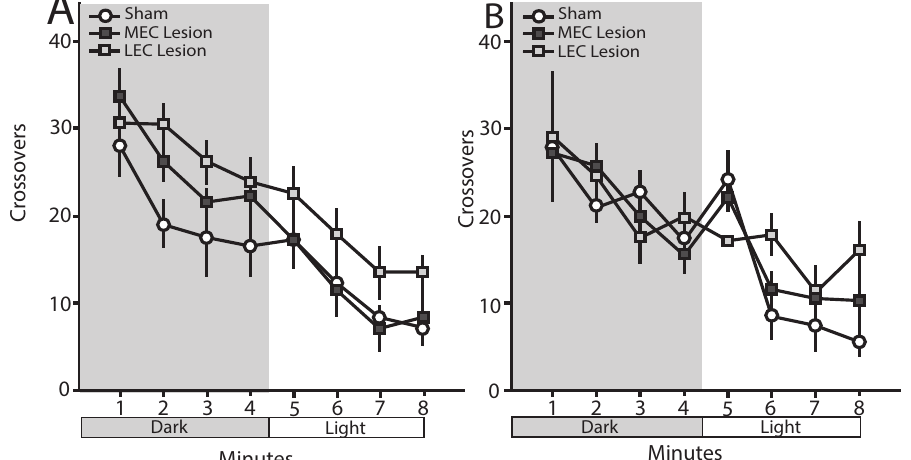
Figure 5. Mean (±SEM) number of crossovers in an open field during a 8-min test with four minutes of dark and four minutes of light. ( A ) Mean crossovers for rats given trace conditioning . There was a significant difference in crossovers across minutes, but no main effect of condition. ( B ) Mean crossovers for rats given delay conditioning . There was a significant difference in crossovers across minutes as well as a crossover X condition interaction. However, there was no main effect of condition.